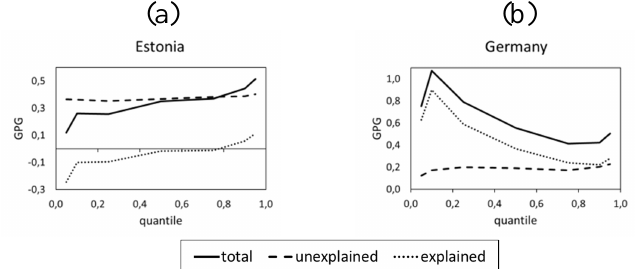
Figure 5. The differences between the log income distributions for men and women vs. quantile rank in the group 3 (a) and the group 4